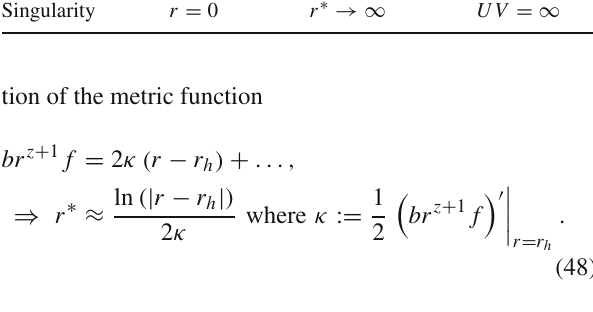
Table 3 Kruskal coordinates representation of the relevant regions of the spacetime Region r -coord r ∗ -coord Kruskal coord Boundary